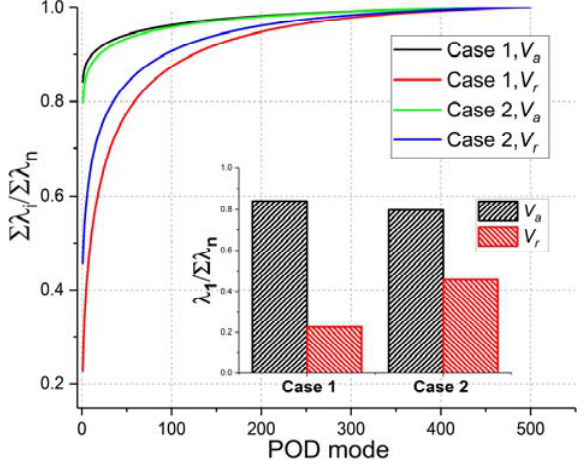
Figure 13. Cumulative energy fraction and the first order mode fraction in Case 1 and Case 2.